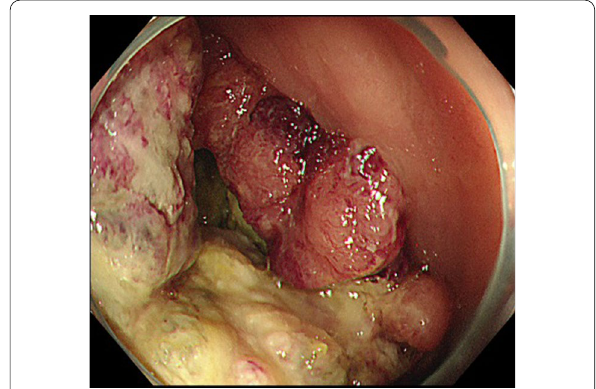
Fig. 1 Colonoscopy findings at initial examination. Colonoscopy revealed a circumferential tumor in the transverse colon